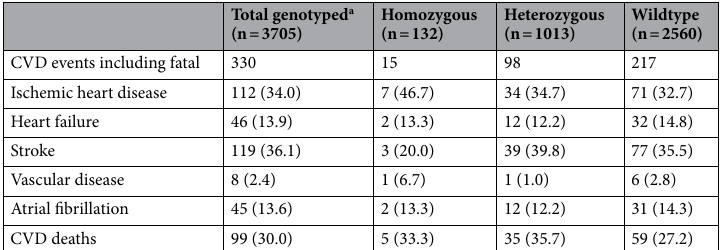
Table 3. TBC1D4 genotype distribution among CVD events. Data are n and (%) of “CVD events including fatal”. a 219 participants missing genotype information